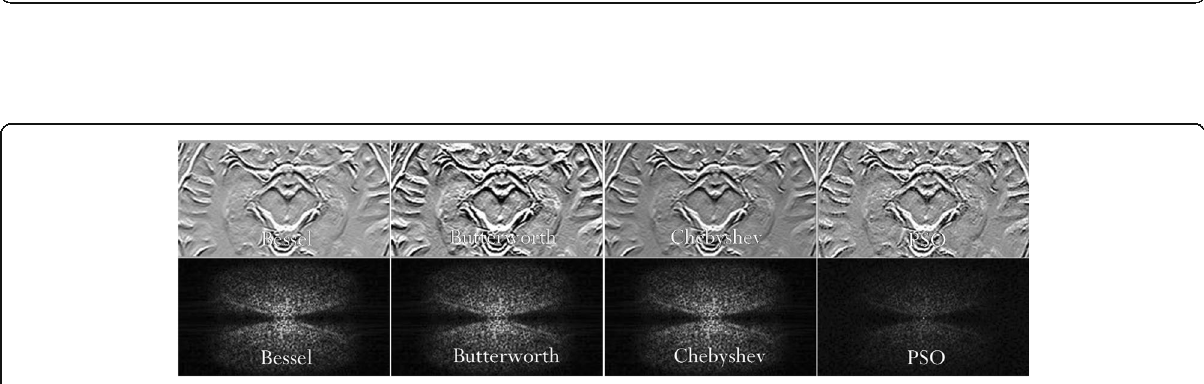
Fig. 10 Normal distribution values, calculated using the formula f ð x ; μ ; σ Þ ¼ ð 1 ffiffiffiffiffiffi p Þ e − ½ð x − μ Þ 2 = ð 2 σ 2 Þ(cid:3) , for the filtered images presented in Fig. 8 [see 2 π σ lines in ( a )] and for the k-space images presented in Fig. 9 [see lines in ( b )]. The plots show cumulative lines. Each line corresponds to an image, and displays the value of f(x, μ , σ ) calculated using the value of ‘ x ’ (which is the histogram data of the image)